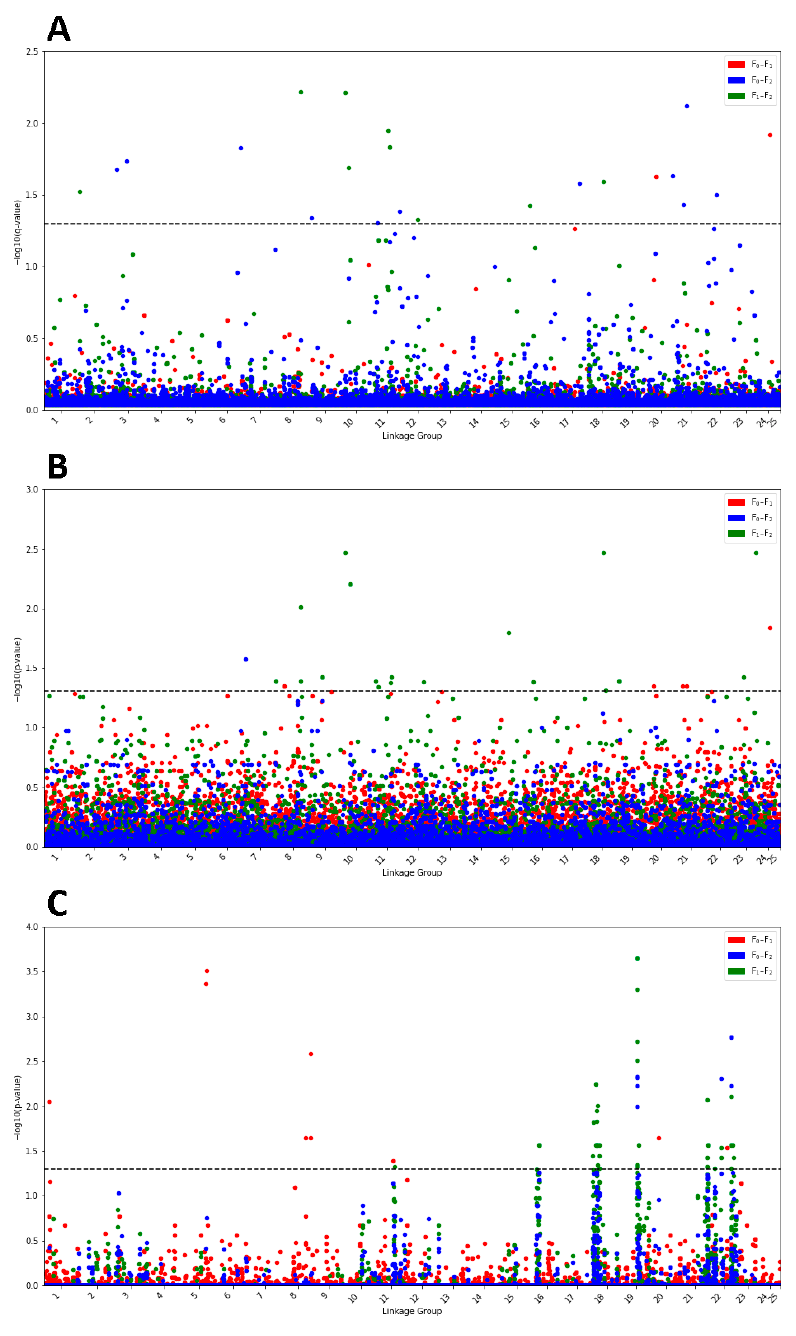
Figure 2. ( A ) Manhattan plot of Bayescan analysis for every locus for every pair of populations. The x-axis displays the linkage group a locus is located. Position on the x-axis indicates the variants’ position in the linkage group. The y-axis shows the − log10 q -value attached to the locus. The dashed line indicates the significance threshold. ( B ) Manhattan plot of LFMM analysis for every locus for every pair of populations. The x-axis displays the linkage group a locus is located. Position on the x-axis indicates the locus’ position in the linkage group. The y axis shows the − log10 q -value attached to the locus. The dashed line indicates the significance threshold. ( C ) Manhattan plot of XP-EHH analysis for every locus for every pair of populations. The x-axis displays the linkage group a